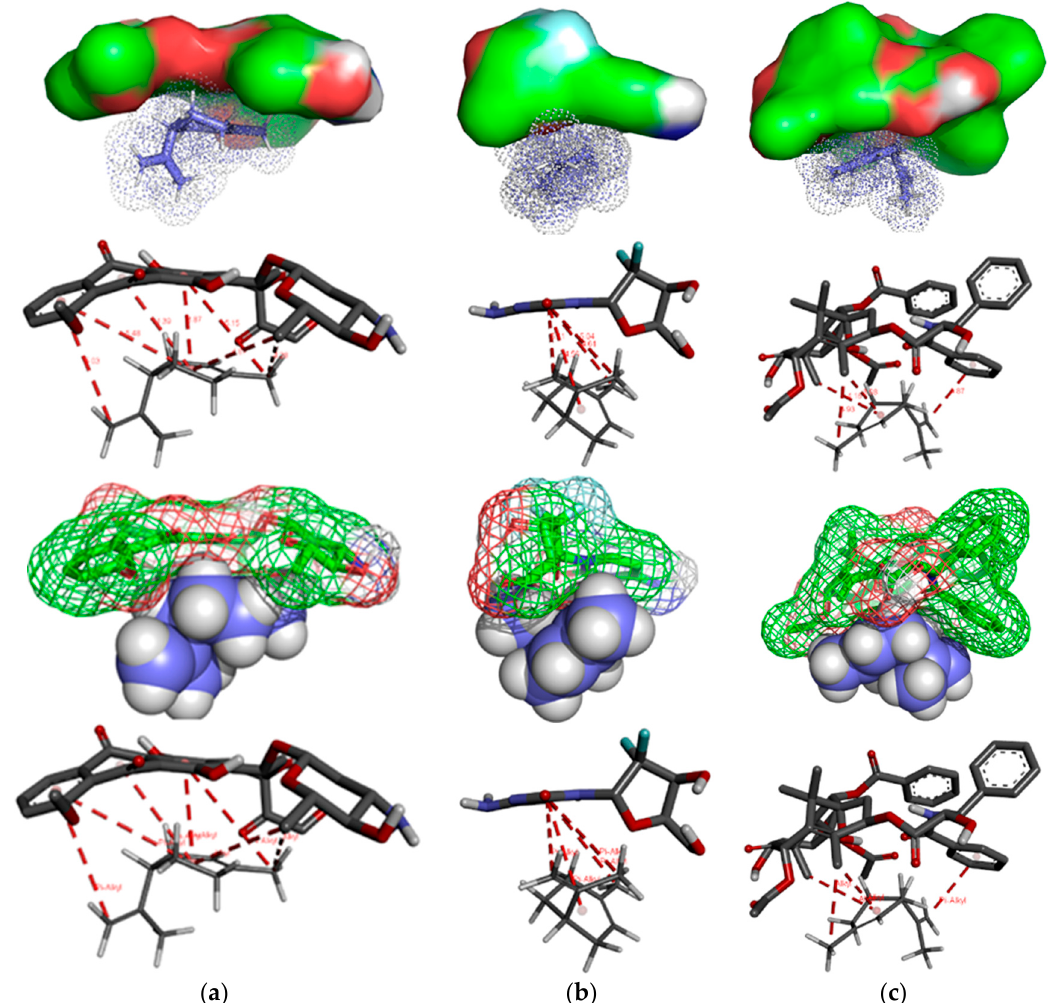
Figure 8. Visualization of the chemotherapeutics-limonene interactions: ( a ) epirubicin–limonene (EPR-LIM); ( b ) gemcitabine–limonene (GCT-LIM); ( c ) paclitaxel–limonene (PTX-LIM).